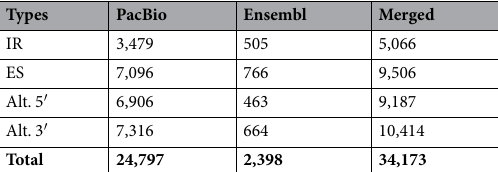
Table 2. Analyses of alternative